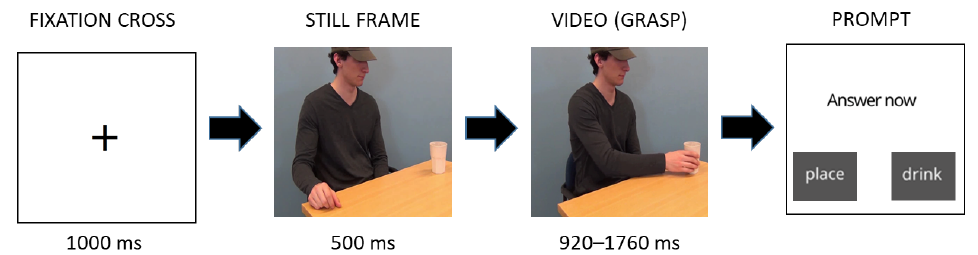
Figure 7. The course of one example trial in experiment 2. The exact duration of the stimuli differed between the stimulus videos (see bottom).